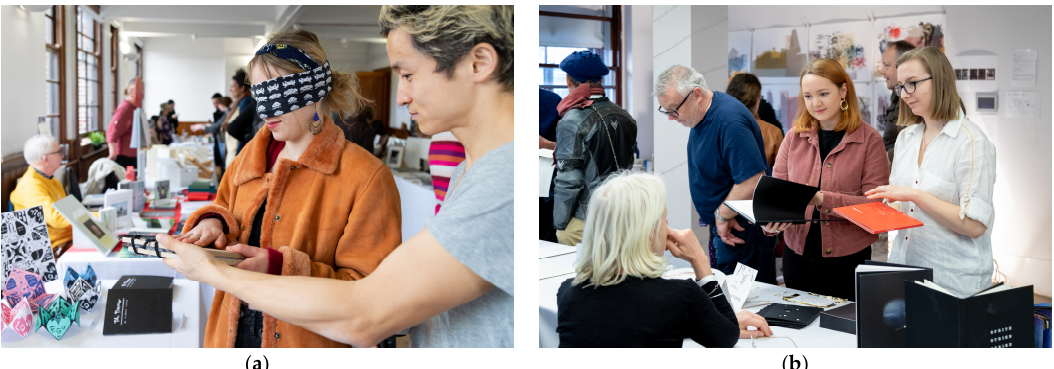
Figure 3. ( a ) Zejun Yao introducing visually impaired visitors to artists’ books at PAGES, The Tetley,